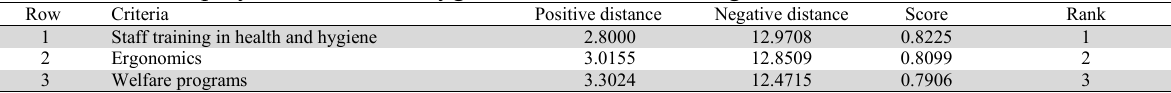
The results of employees' health and hygiene sub-criteria ranking Row Criteria